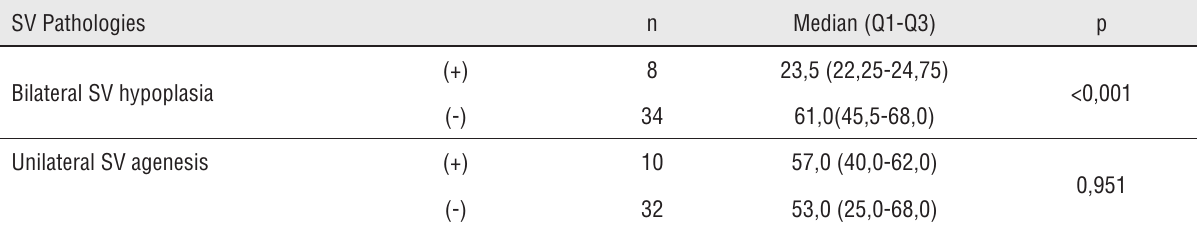
Table 2 - Age distribution in sv pathologies. SV